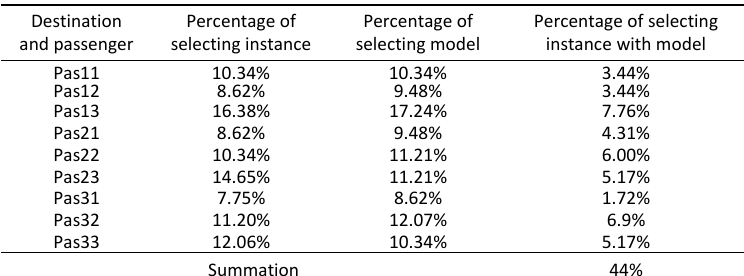
Table 5.Validation for simultaneous multinomial logit model’s data Table 5. Validation for simultaneous multinomial logit model’s Percentage of selecting Percentage of Percentage of Destination instance with model selecting model selecting instance and passenger